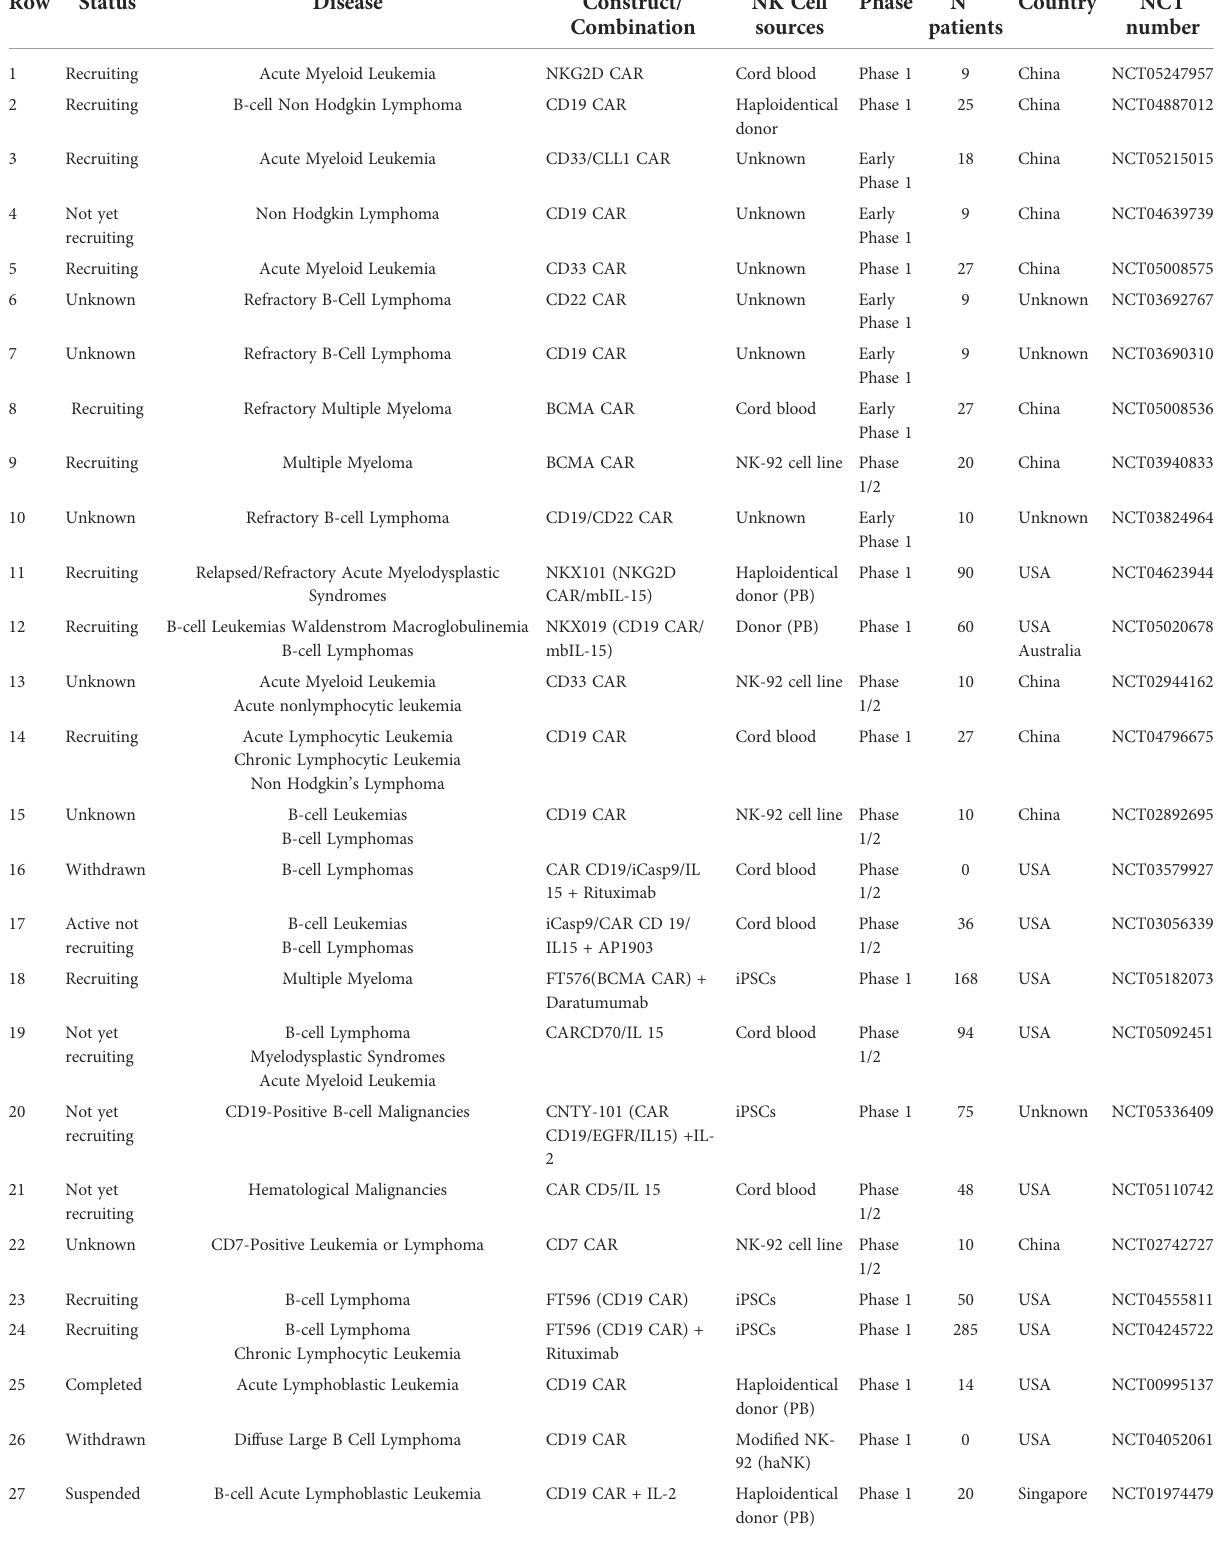
TABLE 1 Current CAR-NK therapy clinical trials in hematological